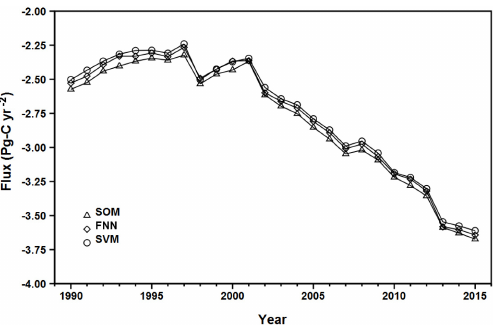
Figure 4. Modeled global CO 2 fluxes. A negative value indicates oceanic